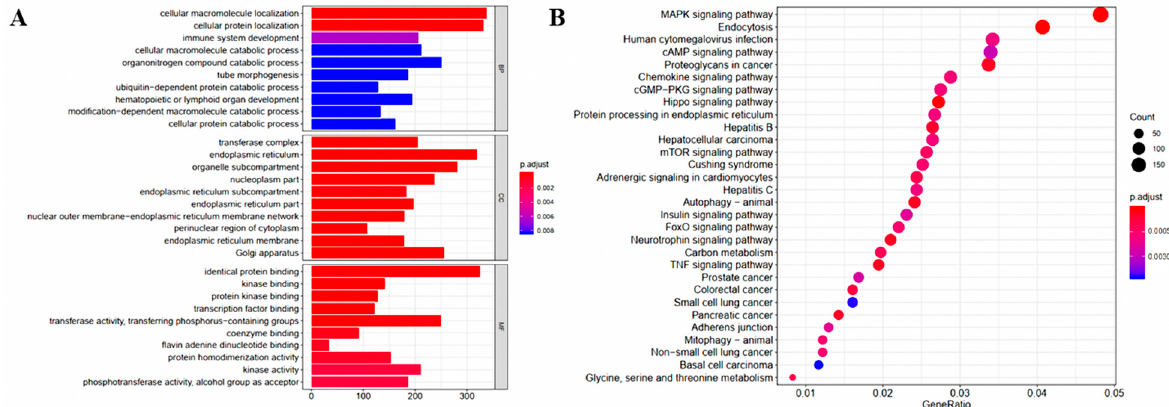
Figure 2. GO classification and pathway enrichment results of differentially expressed genes (DEGs) between liver tissues of the G. elegans -treated group and the control group. ( A ) GO classification of the DEGs. ( B ) Pathway enrichment results of the DEGs. The X axis represents the enrichment factor value, and the Y axis represents the pathway name. The color represents the corrected p value ( p adjust <0.05), and the size of the dots represents the number of genes. GeneRatio represents the proportion of enriched genes to background genes.